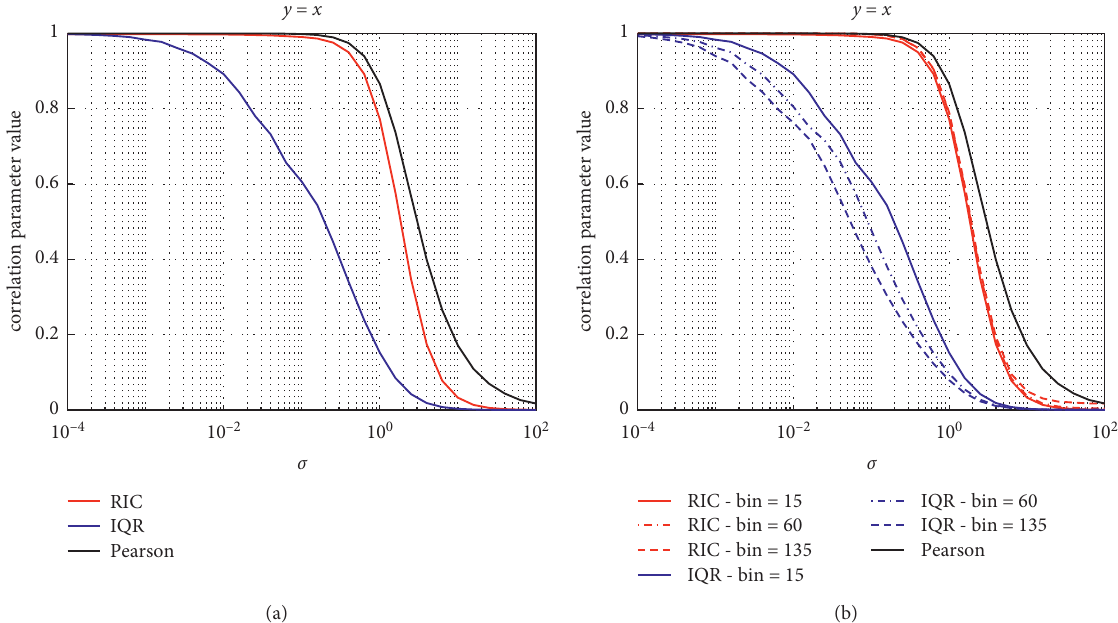
Figure 2: (a) Behavior of PCC, IQR, and RIC with the standard deviation of the additive noise for linear correlations between two variables: y � x . (b) Behavior of PCC, IQR, and RIC with the standard deviation of the additive noise when varying the